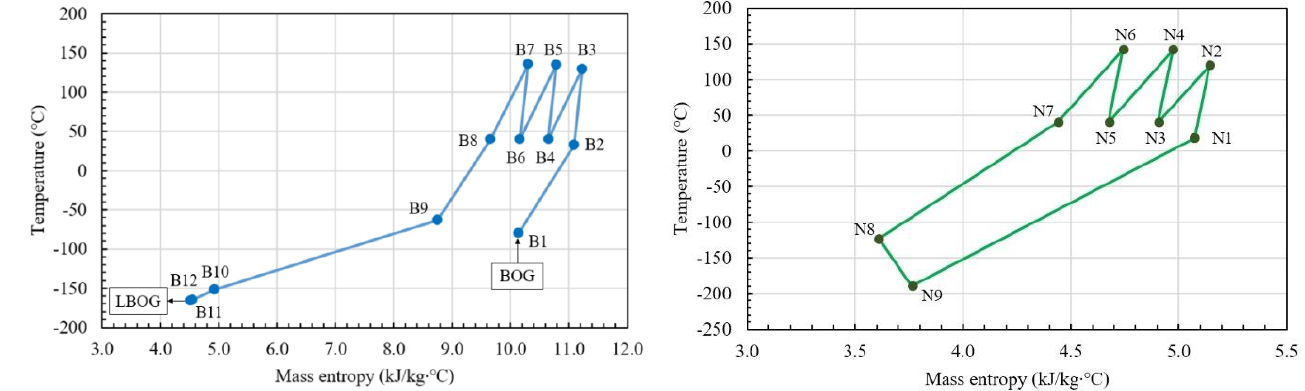
Figure 8. T-S diagram of the BOG re-liquefaction system for Case 1: ( a ) BOG, ( b ) N 2 .